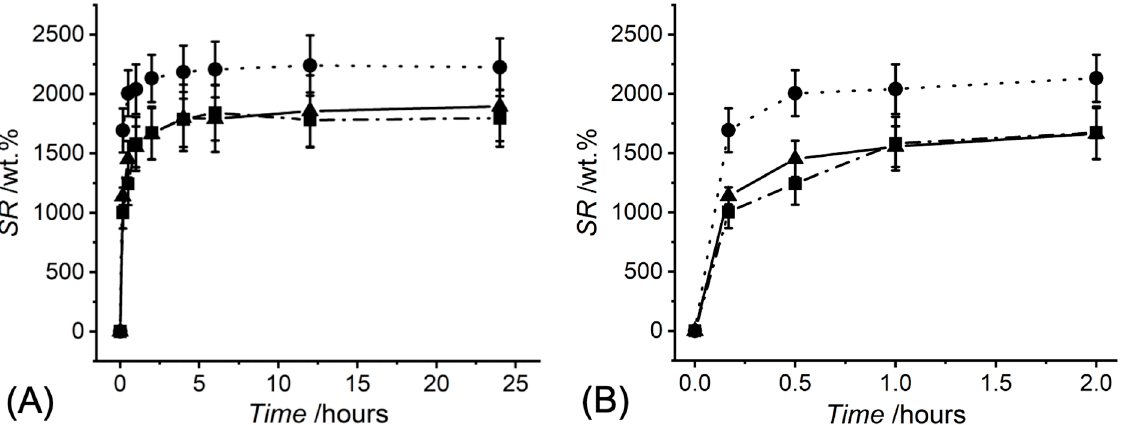
Figure 6. Temporal profiles of SR following either 24-h ( A ) or 2-h ( B ) incubation of dry UV-cured collagen networks ( n = 9) in 10 mM PBS (pH 7.4, 25 °C). Black dot, P-4VBC*; black dash dot, B-4VBC*; black solid, R-4VBC*.